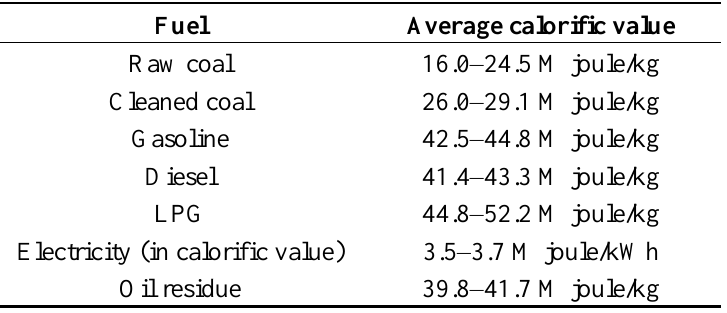
Table 2. Conversion factors from physical units to thermal units [28,29].